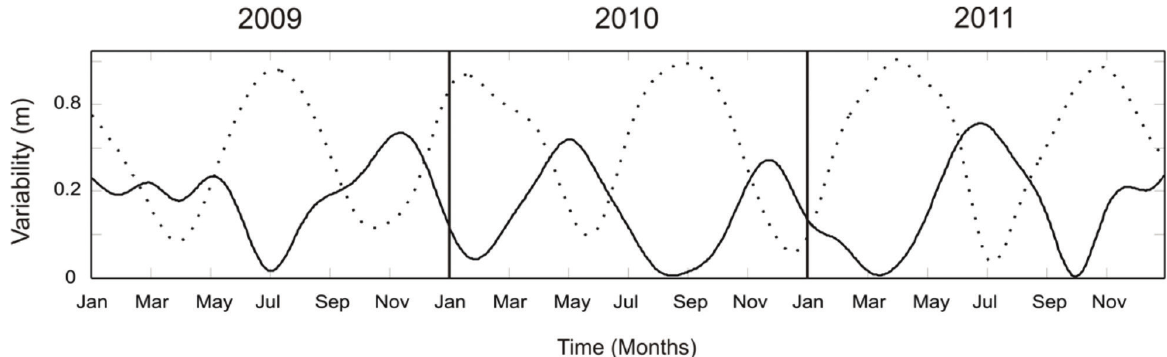
Figure 5 - Temporal variability between consecutive neap (full line) and spring (dashed line) tides for the years 2009, 2010 and